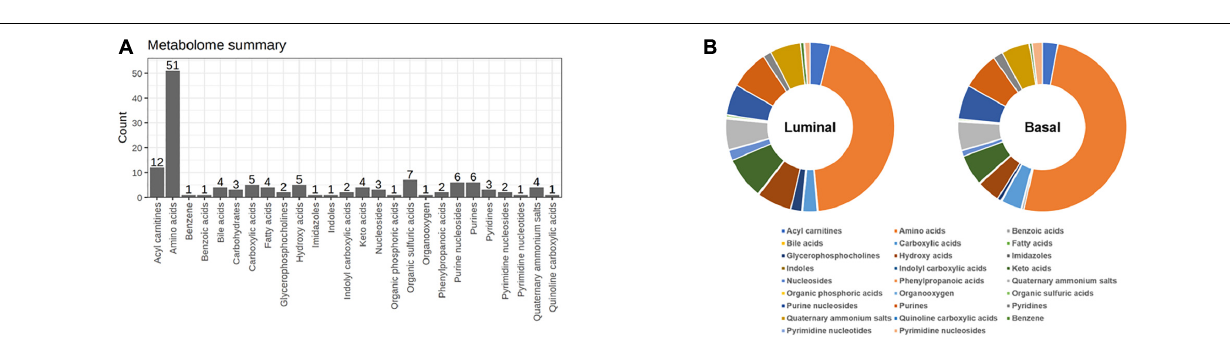
differential lipid elements between the basal and